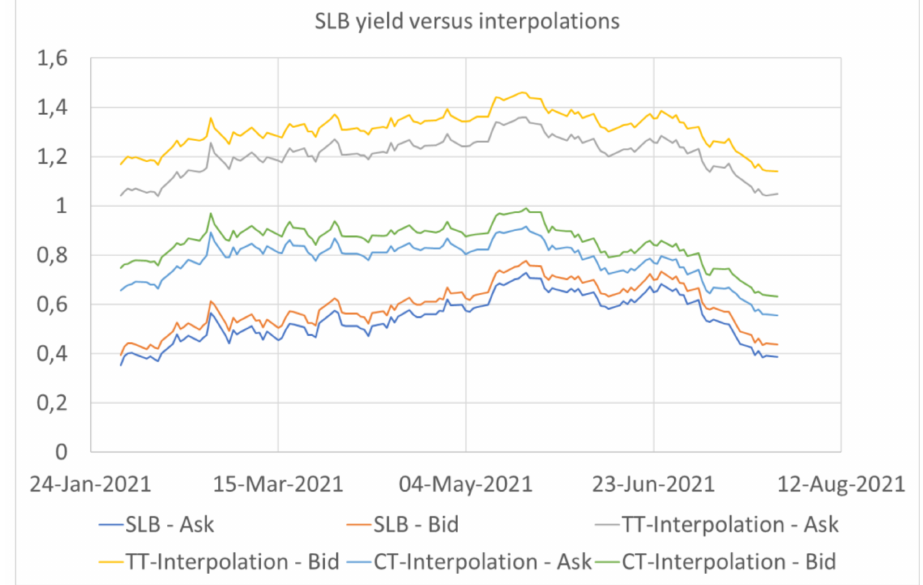
Figure 2. SLBs yields versus interpolations 29 January 2021–26 July 2021 (in %).